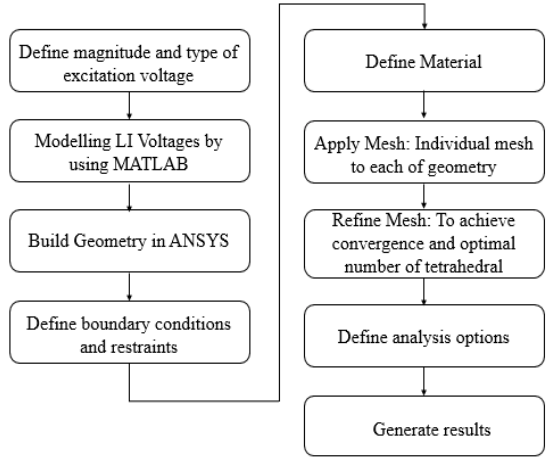
Figure 8. The process flow of simulation work using ANSYS.